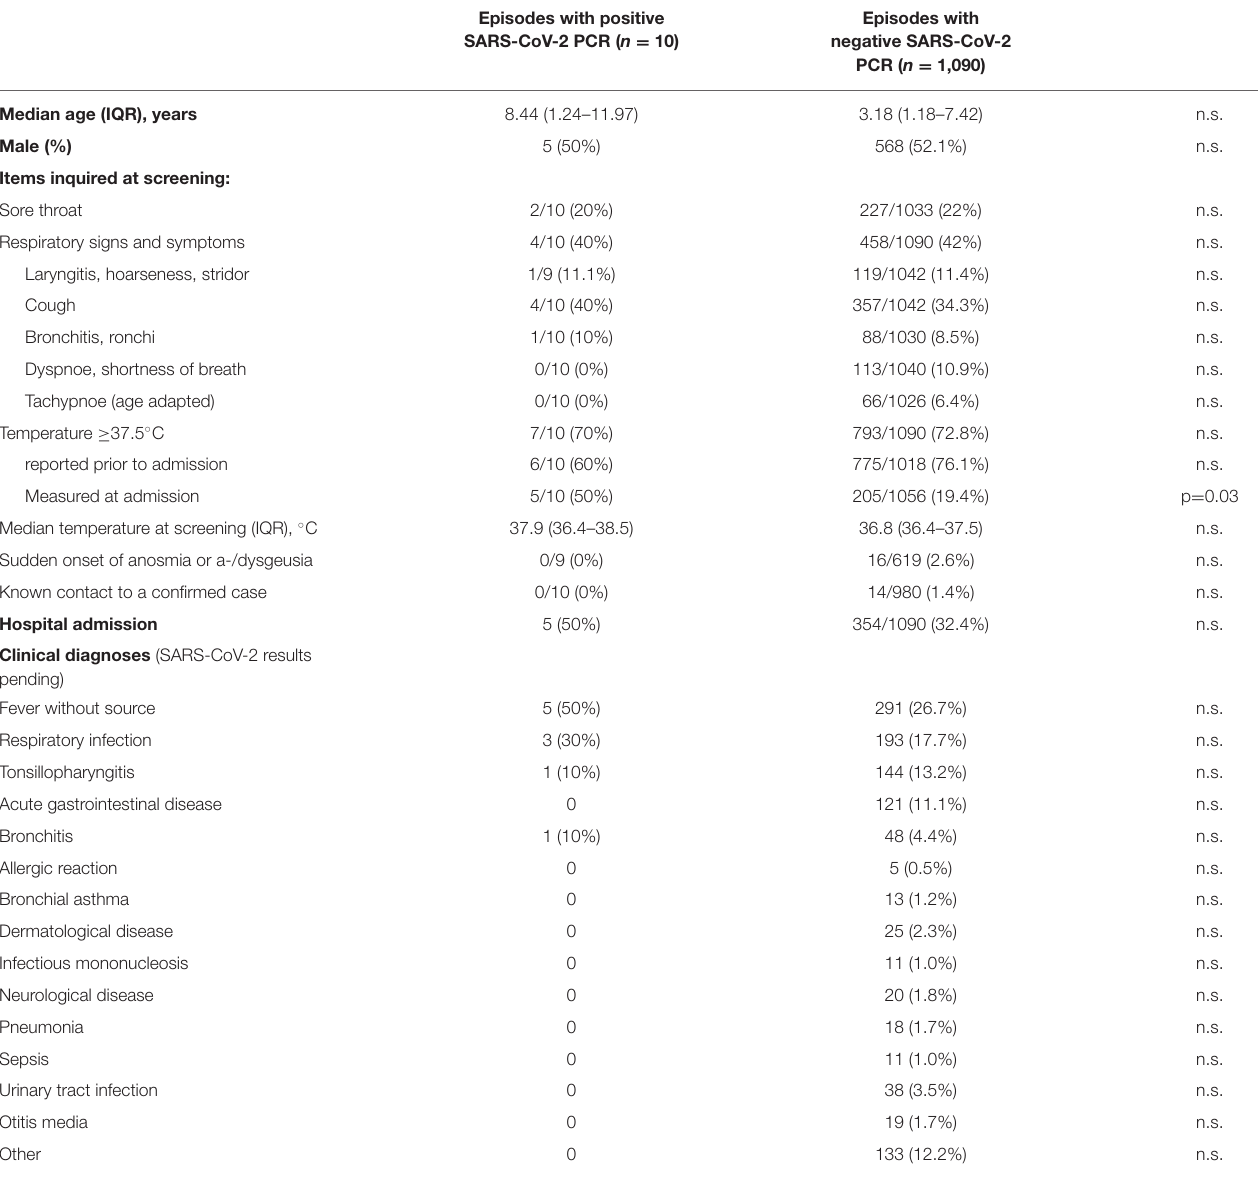
TABLE 1 | Characteristics of patients and items evaluated with the screening questionnaire based on national clinical case definitions for suspected SARS-CoV-2 infections and the frequencies of these criteria in pediatric patients with or without SARS-CoV-2 infection.